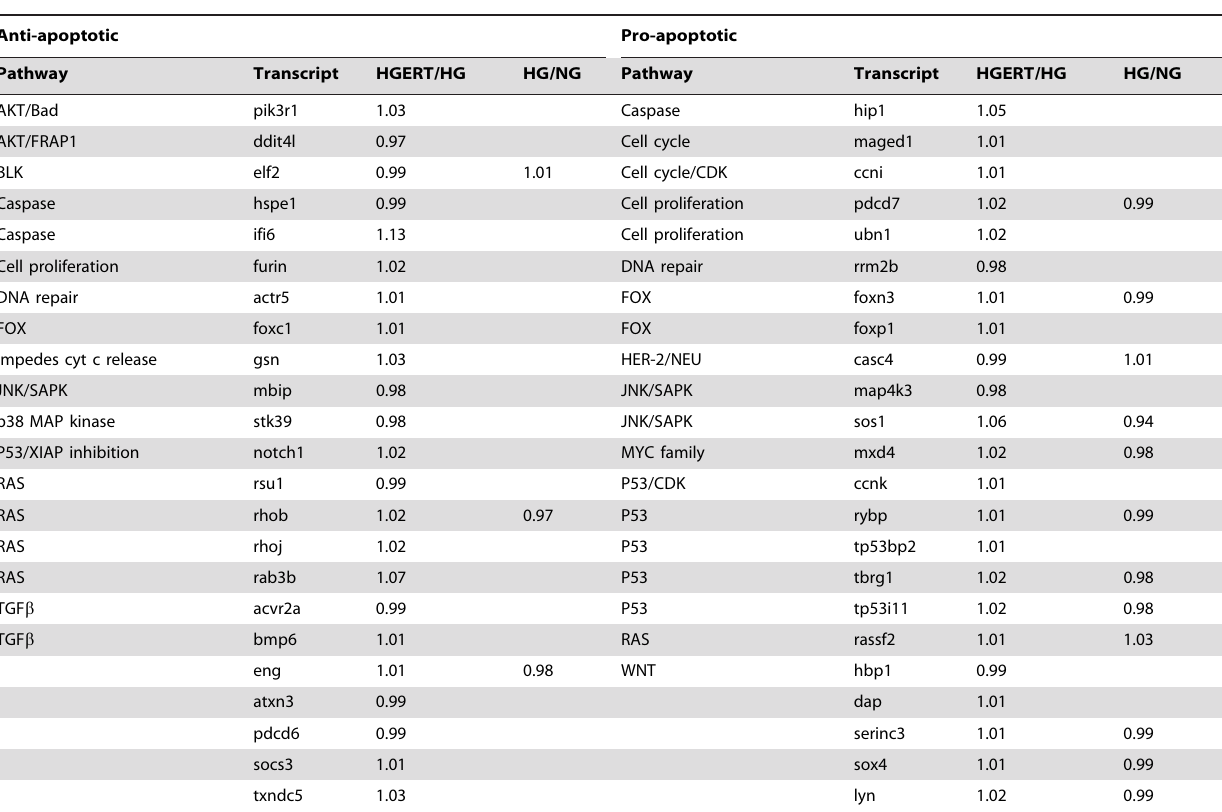
Table 2. Altered transcripts with a link to